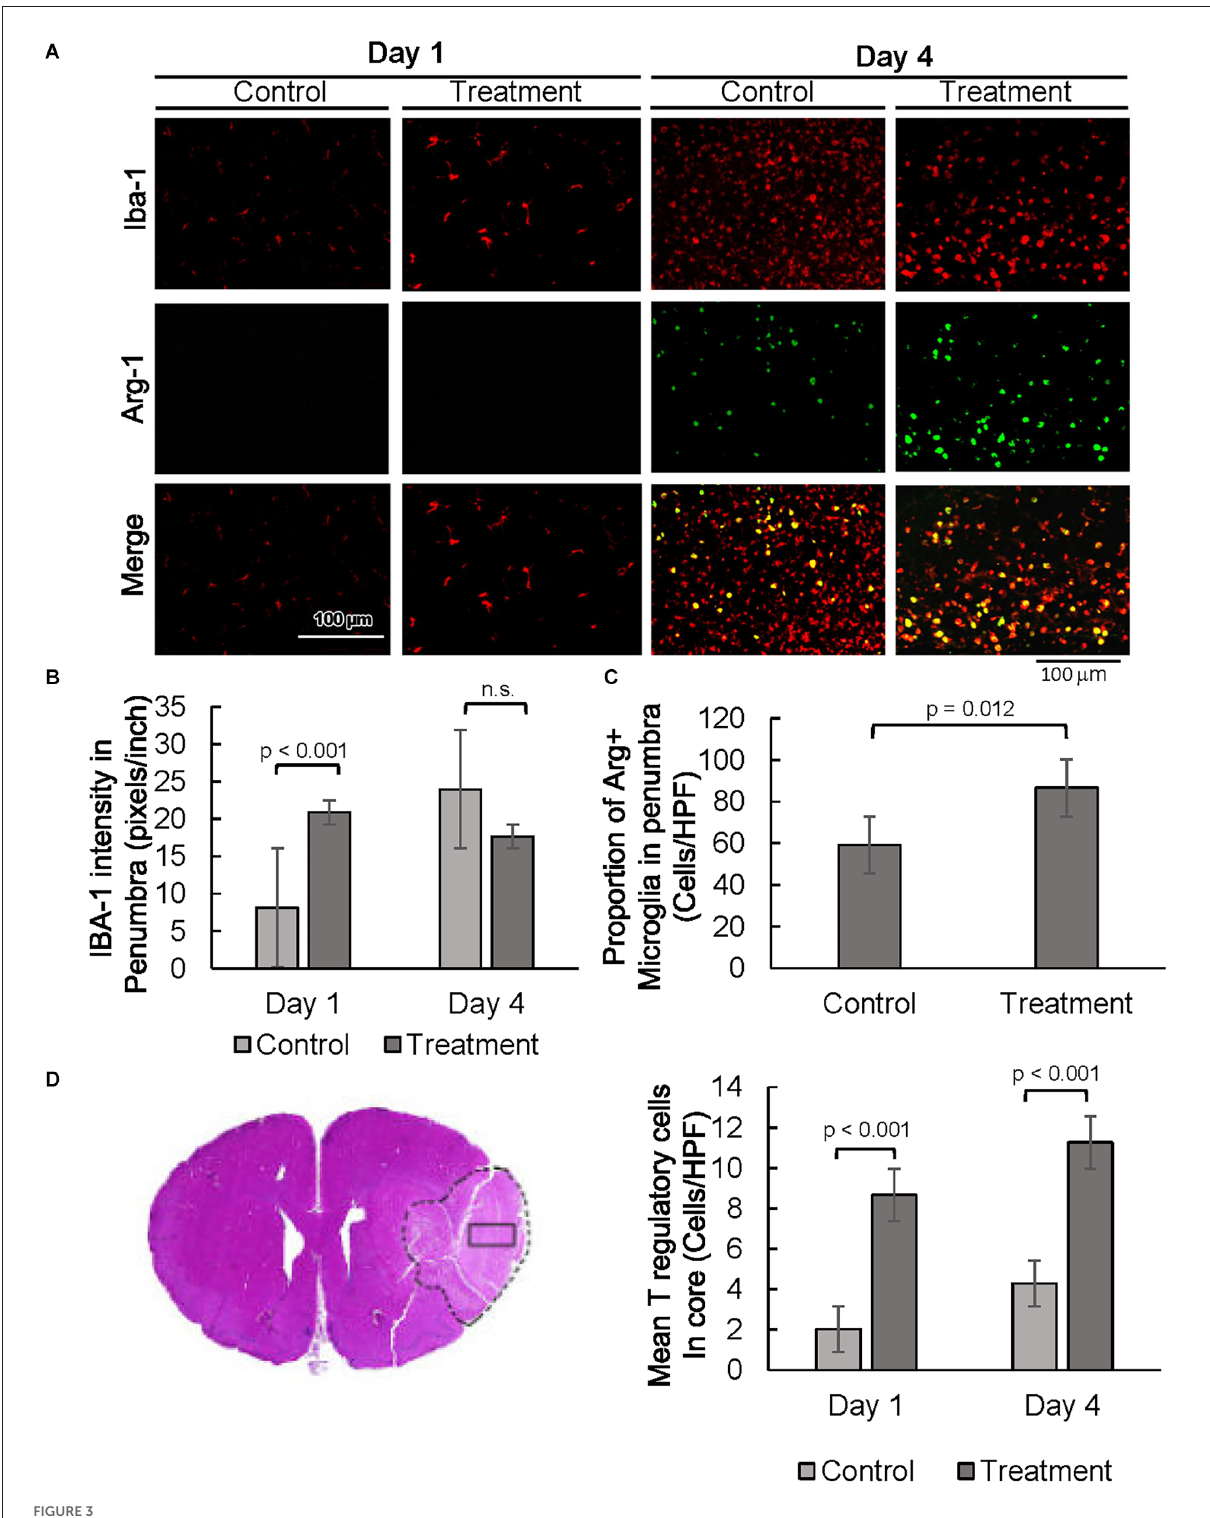
FIGURE3 SRC activation promotes a pro-reparative immune response. (A) Representative images of IBA1 and ARG1 immunostaining showing per cent of pro-reparative M2 microglia 1 day and 4 days post-MCAO R. (B) Quantification of mean IBA1 intensity 1 and 4 days post-MCAO R. Day 1 and day 4 n = 10 control, 10 drug-treated, three images per section. (C) Quantification of IBA1 positive and ARG1 positive cells at day 4. (D) Quantification of average numbers of Tregs in the core infarct. Day 1 and day 4 n = 10 control, 10 drug-treated, three images per